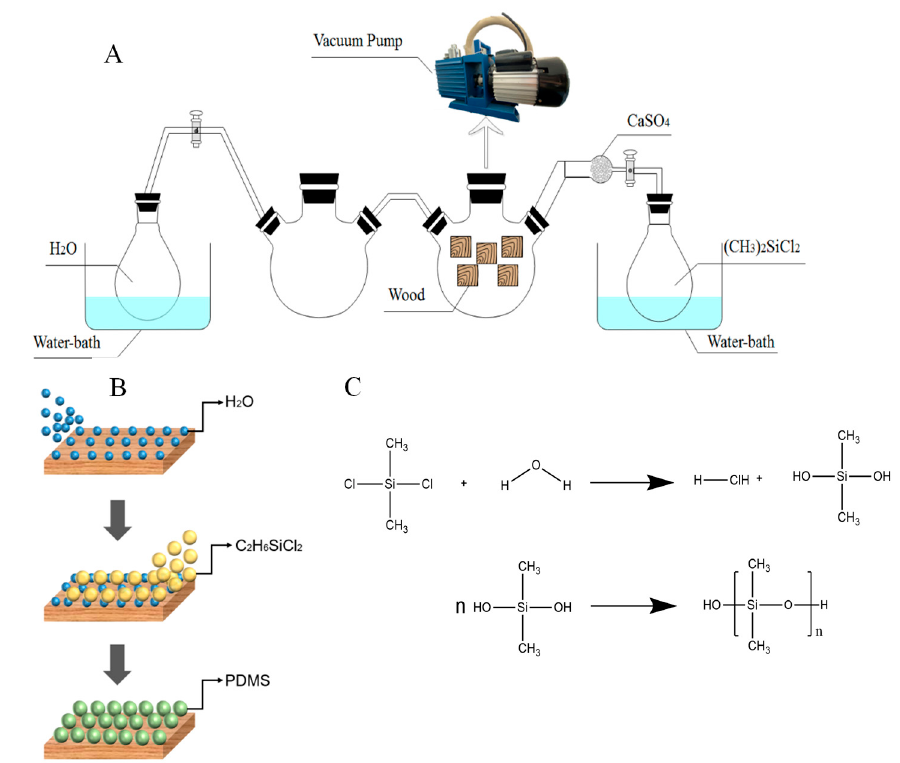
Figure 2. Low-temperature chemical vapor deposition (CVD) treatment of wood. ( A ) The device set-up of the treatment and ( B ) illustration of the formation of PDMS on the wood surface, including (I) moisture deposition onto the wood surface, (II) introducing C 2 H 6 SiCl 2 vapors onto the wetted